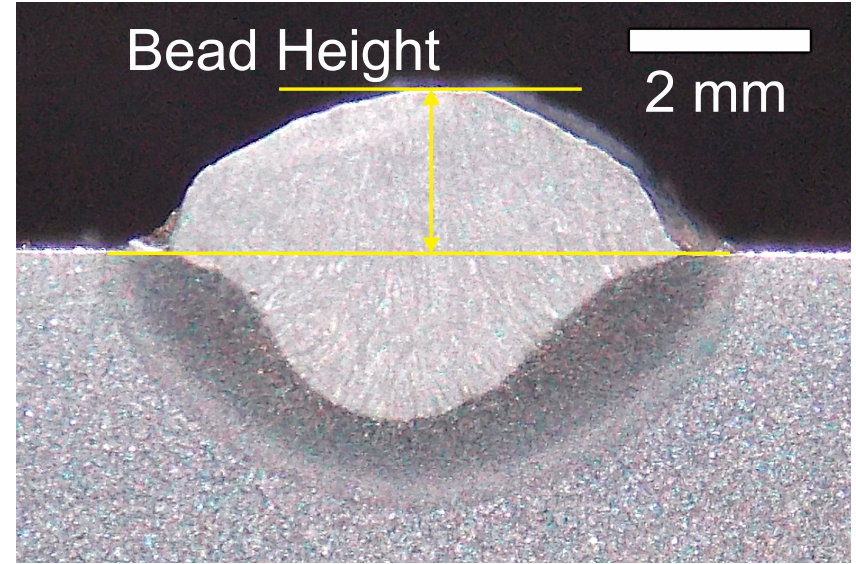
Figure 14. Test specimen optimized in relation to the smallest bead height of the weld bead.